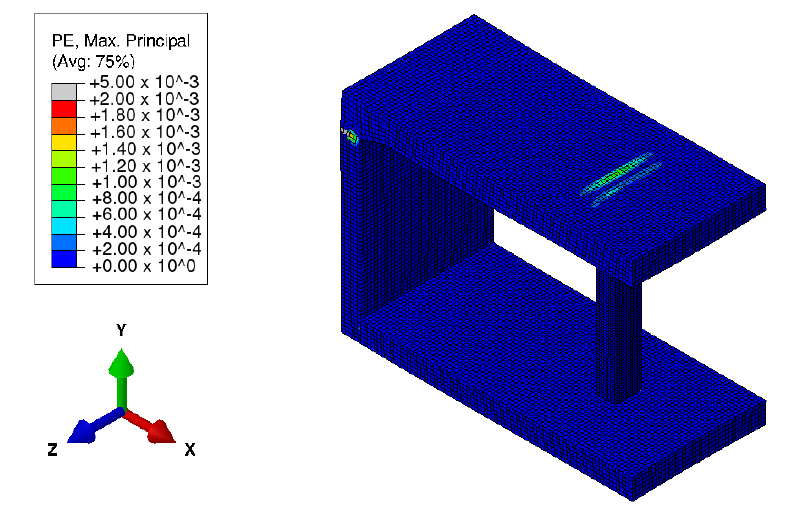
Figure 23. Plastic strains, developed on the outer surface of the top slab at its connection to the column right before the onset of cracking, as obtained from a thermomechanical simulation based on temperature-dependent and elasto-plastic material behavior, as well as on the prescription of one uniform surface temperature history; the results refer to the time instant 13 min and 50.5 s after the beginning of the fire test.